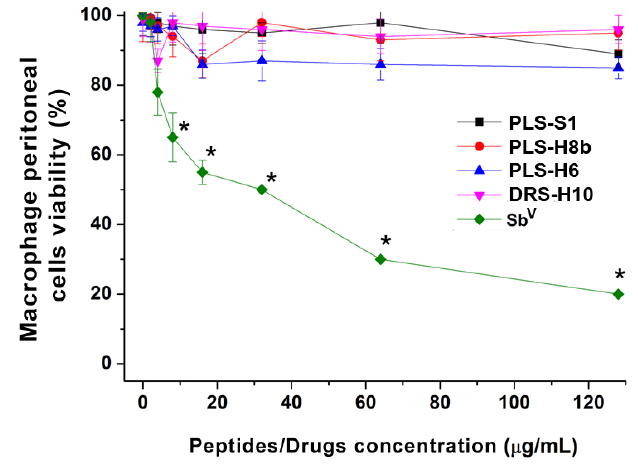
Figure 4. Effect of antimicrobial peptides from Phyllomedusa nordestina on macrophage peritoneal cells as measured by the MTT assay. The dispersion bar represents the standard deviation of three independent experiments with reproducible results. (*) p < 0.05 when compared to the